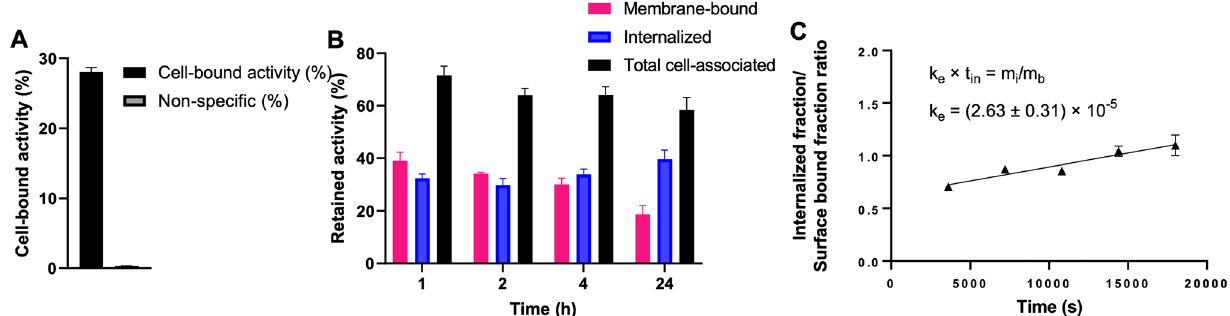
Figure 2. Cell uptake, retention and internalization assays for iso -[ 131 I]SGMIB-VHH_1028 on HER2- positive BT474 breast carcinoma cells. ( A ) Total cell-bound activity and non-specific binding, measured by co-incubation with 100-fold excess of trastuzumab, after a 1 h incubation at 4 °C. ( B ) Retention of 131 I activity after incubation at 37 °C for various times expressed as membrane-bound, internalized and total cell-associated activity; corrected for nonspecific binding by co-incubation with trastuzumab and ( C ) Internalization rate determined by plotting the ratio of internalized fraction over surface bound fraction, corrected for nonspecific binding, over time; internalization rate constant (k e ) derived by linear regression (R 2 = 0.8471). Surface-bound % activity and internalized % activity are presented as the percentages of initially cell-bound radioactivity after an initial incubation at 4 °C in these compartments. Surface-bound + internalized + supernatant = 100% at all time points.